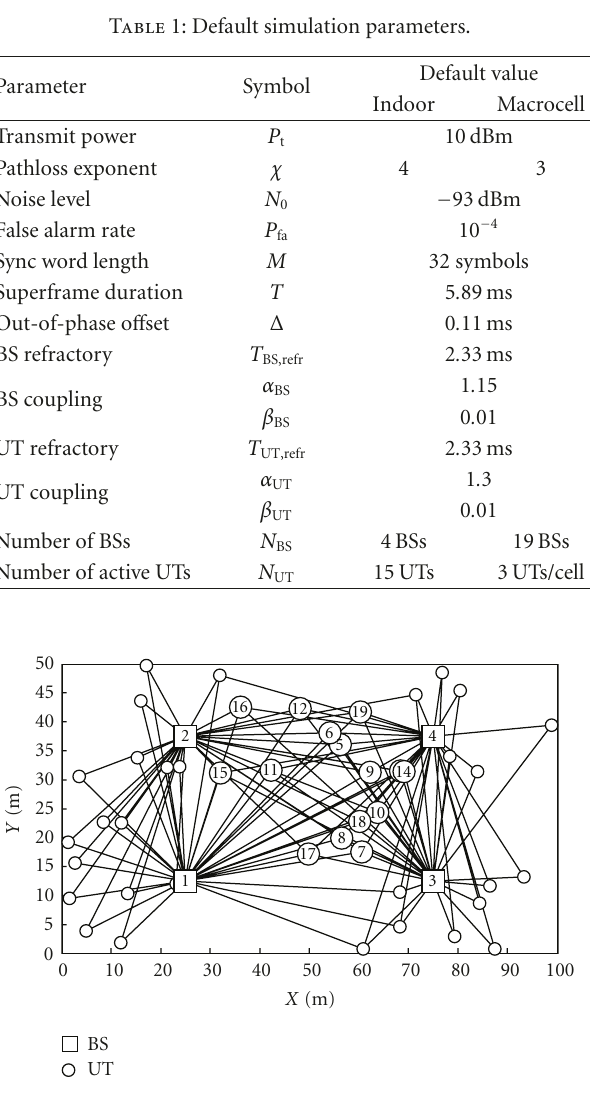
setting was defined for the local area scenario in WINNER [27]. The network topology with N BS = 4 BSs and N UT = 15 UTs participating in CelFSync is depicted in Figure 8. The selected UTs (marked as bold circles) can communicate directly with all BSs (marked as squares). UTs that do not participate in the network synchronization procedure do not transmit UL Sync and adjust their slot oscillator based on received DL Sync